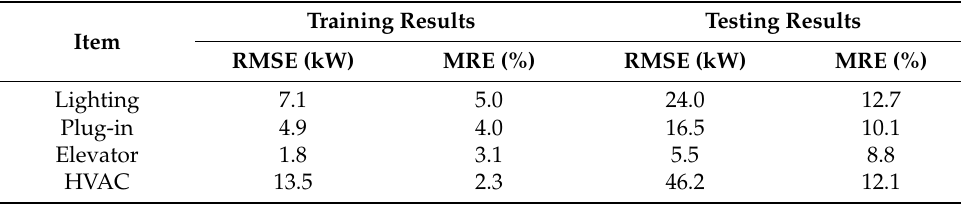
Table 4. Training and testing results of NIM models based on Approach II.